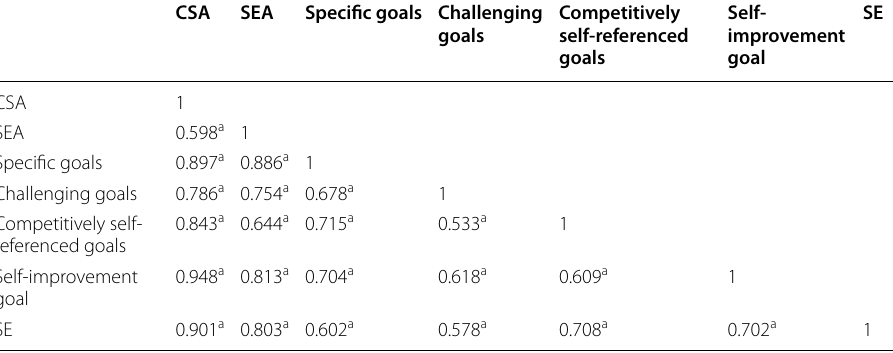
a Correlation is significant at the 0.01 level (2-tailed)